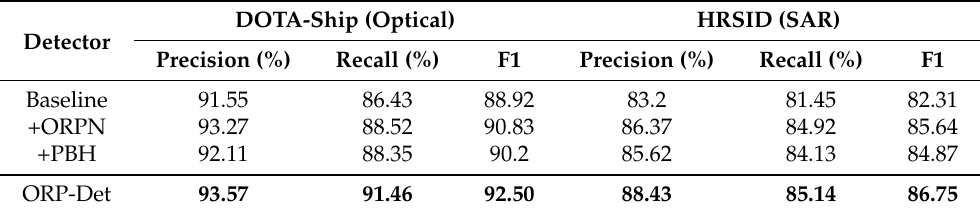
Table 5. Ablation experiments for ORP-Det.